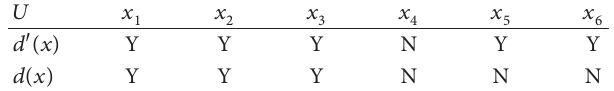
Table 10: The difference of decision